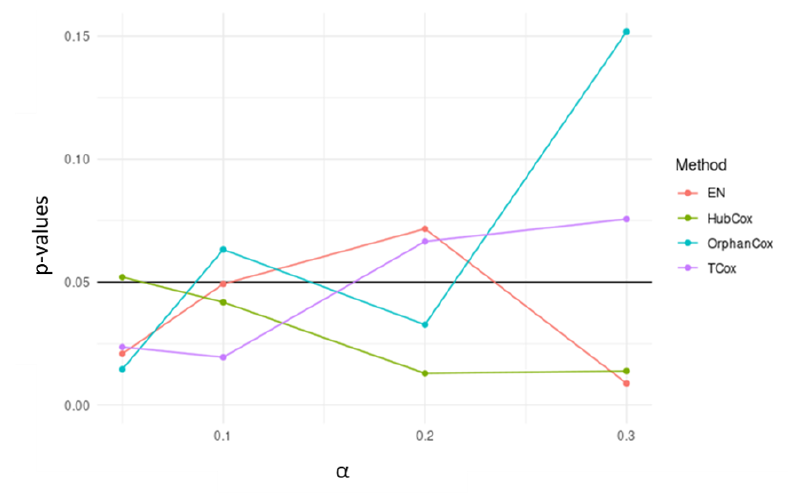
Figure 4. p -values obtained for survival models applied to the test sets, using different α -values.